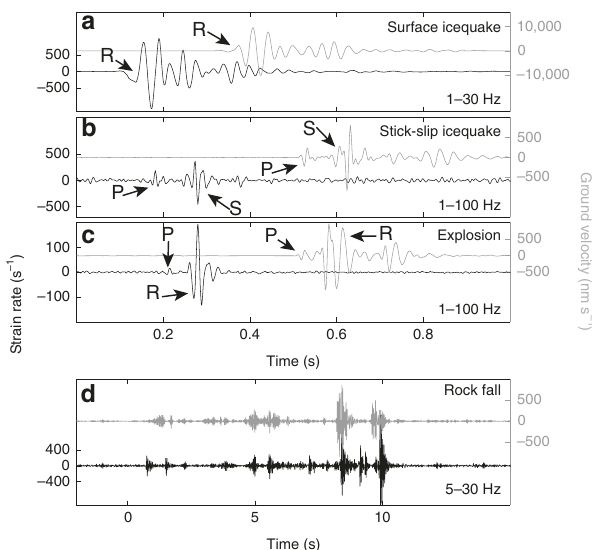
Fig. 2 Microseismic events. a Bandpass fi ltered seismograms (vertical seismometer record in gray and DAS record in black) of surface icequake, b stick-slip icequake, c explosion, and d rockfall. Time series in panels ( a – c ) were recorded at southern triangle corner (seismometer RA53 and DAS channel D620). Time series in ( d ) was recorded at western triangle corner (RA52 and channel D904). Note that the time axes between DAS and seismometers records in panels ( a – c ) were slightly shifted for illustration purposes. Filter corners are speci fi ed. For surface icequake ( a ), stick-slip icequake ( b ), and explosion ( c ), P-, S- and/or Rayleigh phases are